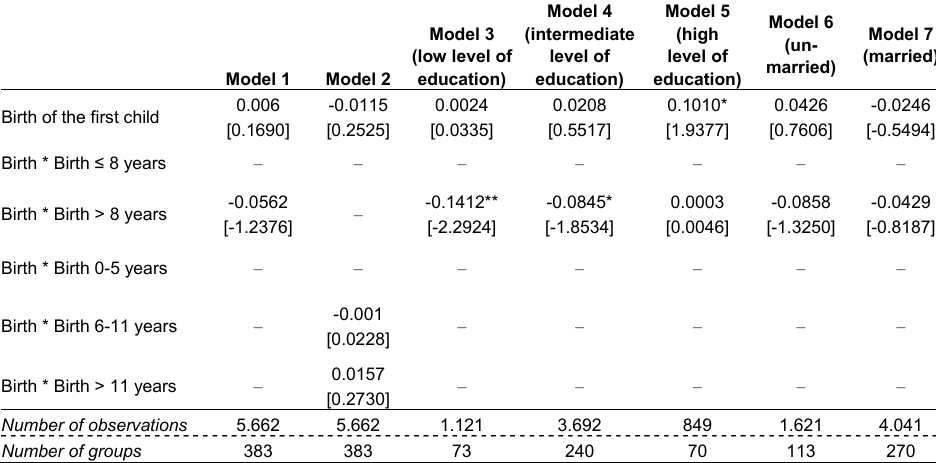
Fixed-effects results based on the ‘relative’ age at first birth (  -coefficient, t-values in